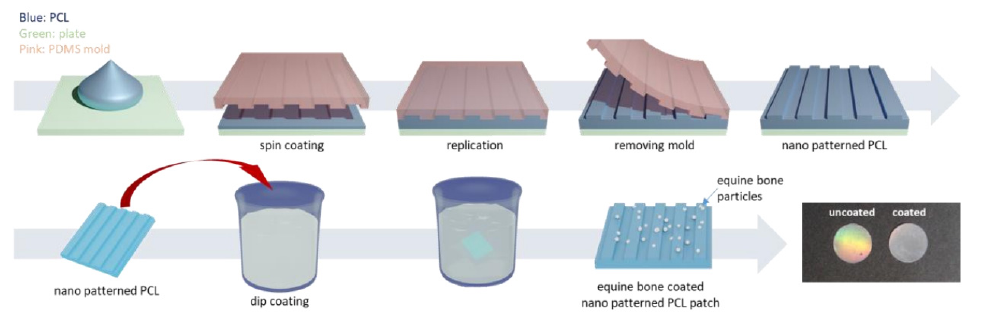
Figure 5. The preparation of equine bone powder (EBP)-coated polycaprolactone (PCL) nano- patterned patches, reprinted from Ref. [43].